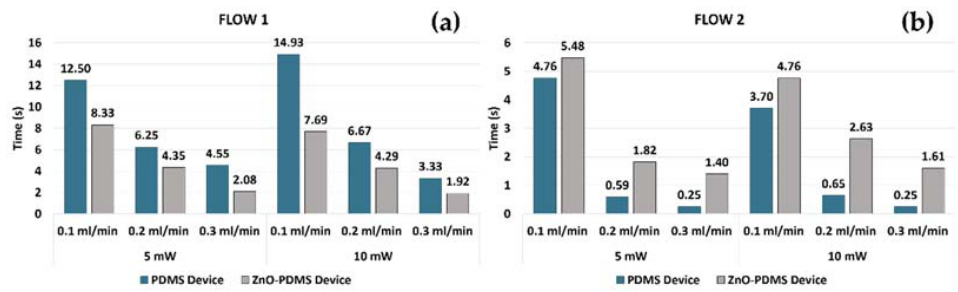
Figure 11. T period measured in EXP1 and EXP2 conditions for FLOW1 ( a ), and FLOW2 ( b ), in PDMS mofd and ZnO-PDMS mofd . mofd and ZnO-PDMS mofd